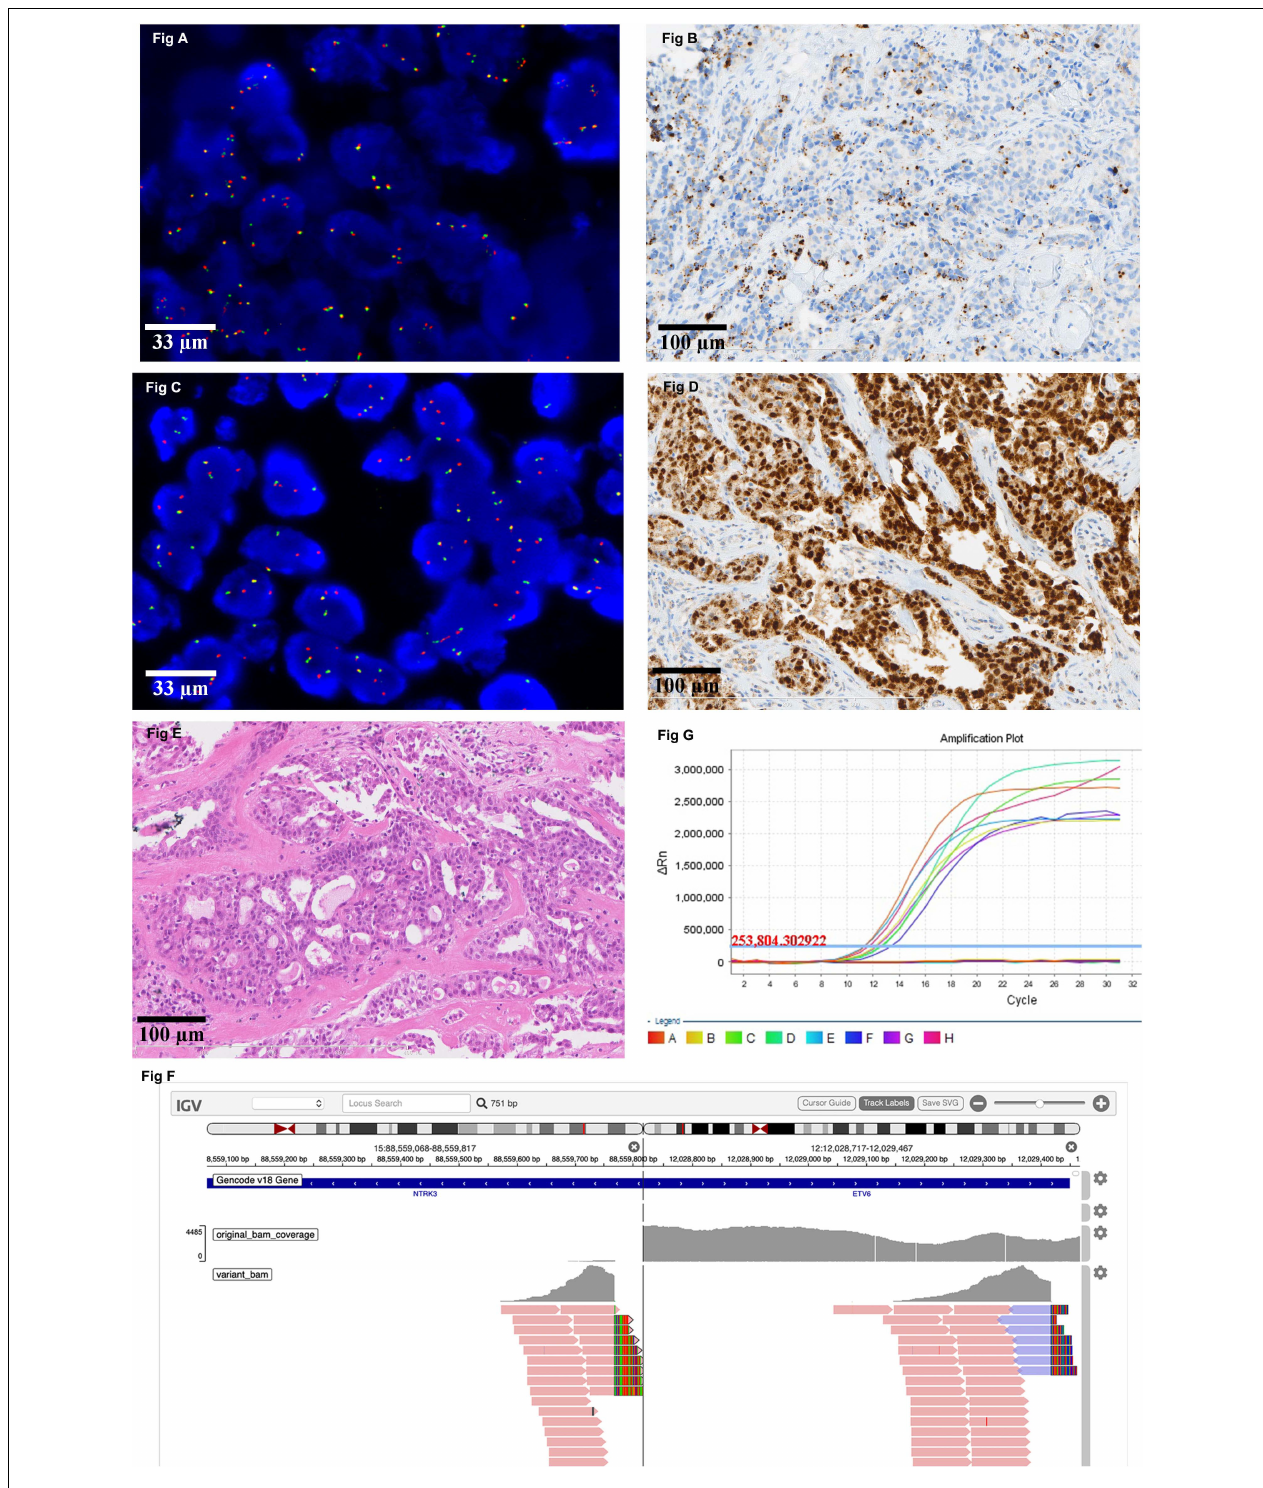
FIGURE 1 | Representative image of NTRK result detected by different platforms. (A) There is a positive NTRK1 FISH signal in 22% of the tumor cells (630X). (B) The corresponding IHC result of the case in Figure A showed a strong cytoplasmic stain in 80% of the tumor cells (200X). (C) There is a positive NTRK3 FISH signal in 88% of the tumor cells (630X). (D) The corresponding IHC result of the case in Figure C indicated a strong and diffuse nuclear stain in almost all tumor cells (200X). (E) The morphology of the case which the diagnosis was modified from breast carcinoma, no special type, to secretory breast carcinoma (100X). (F) Positive NTRK3 result detected by DNA-based NGS. (G) Representative image of negative NTRK result detected by RT-PCR.